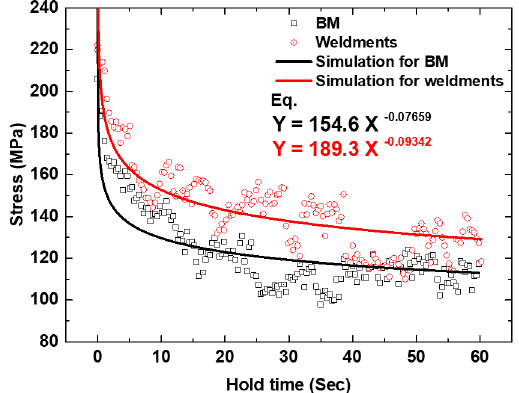
Figure 12. The stress relaxation behavior (SRB) during maximum tensile HT at stable cycle. LCF-HT test at 0.6% total strain range.